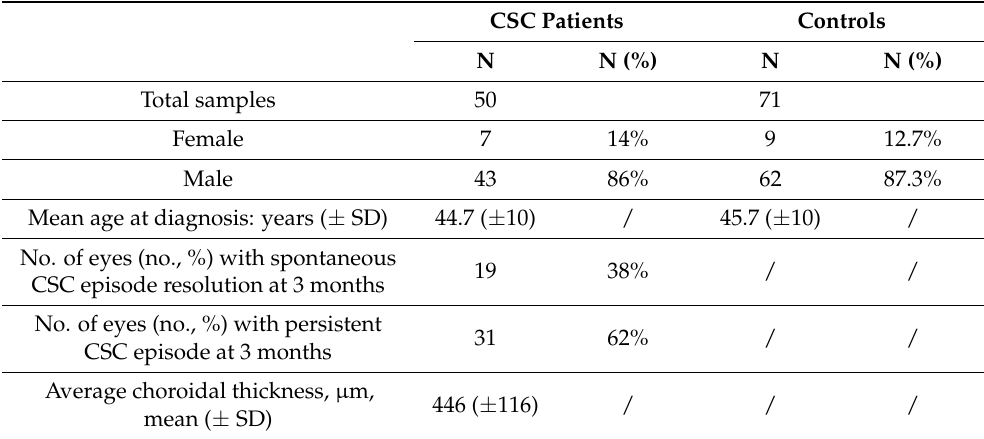
Table 2. Characteristics of investigated acute central serous chorioretinopathy (CSC) patients and healthy